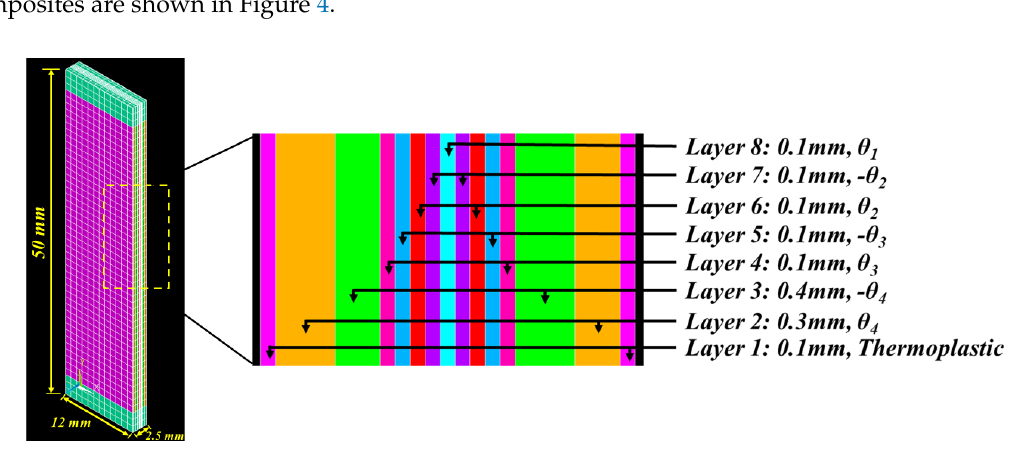
Figure 4. Finite element model and fiber layup for the multi-angled laminate.